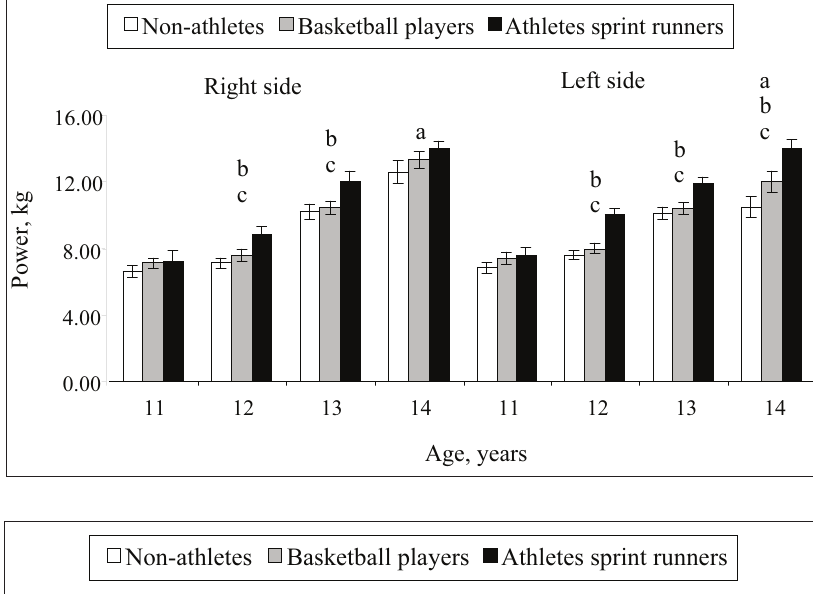
athletes sprint runners